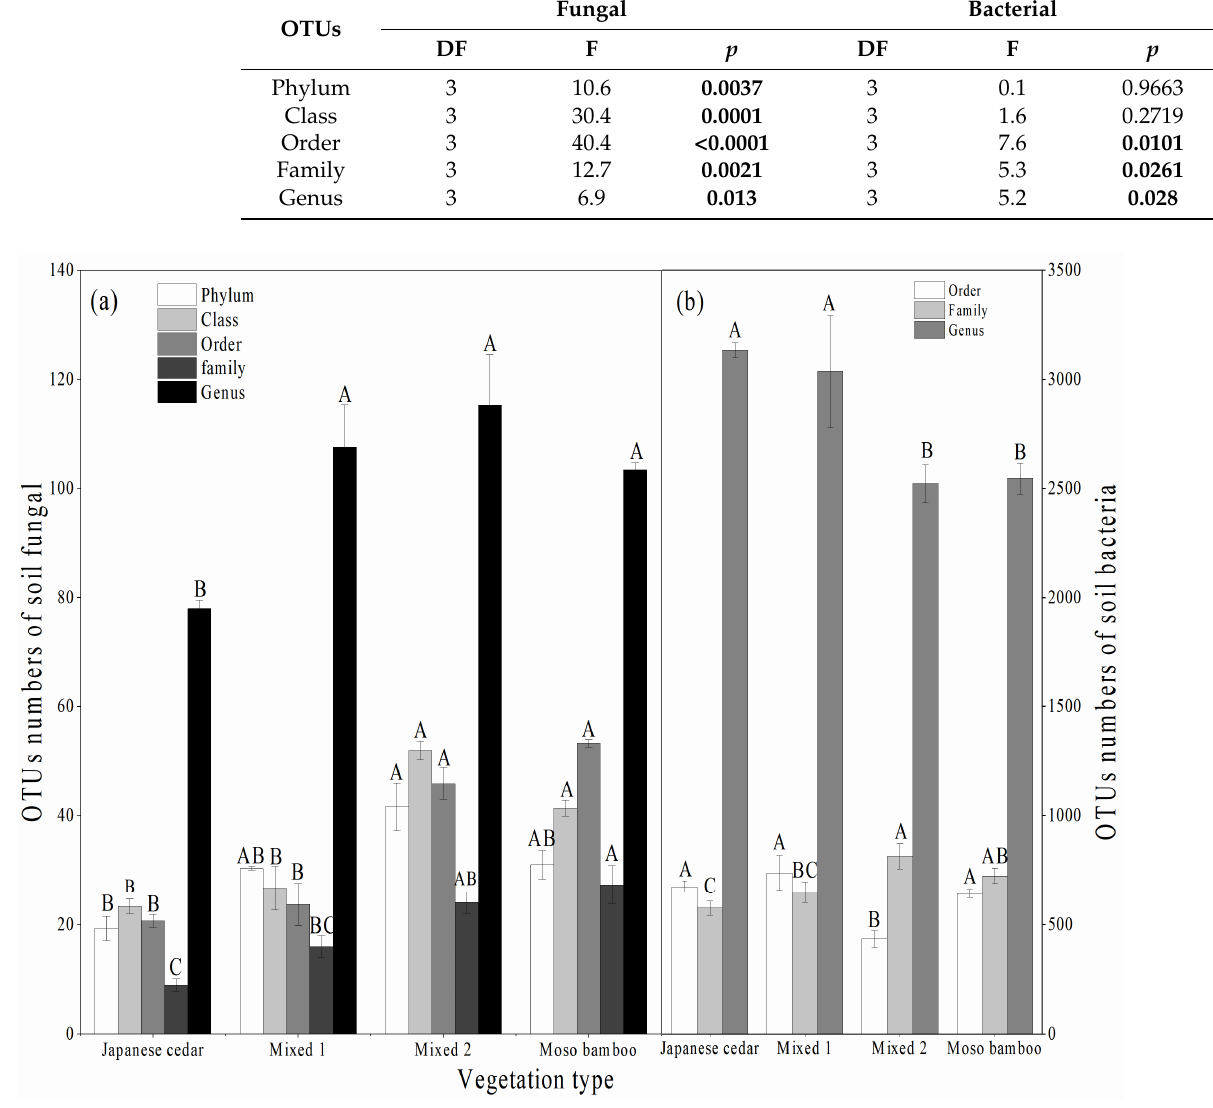
Figure 1. Effect of different vegetation types on the number of soil fungal and bacterial OTUs (means ± se): ( a ) number of soil fungal OTUs, ( b ) number of soil bacterial OTUs. Different letters above columns in the same color indicate significantly different.